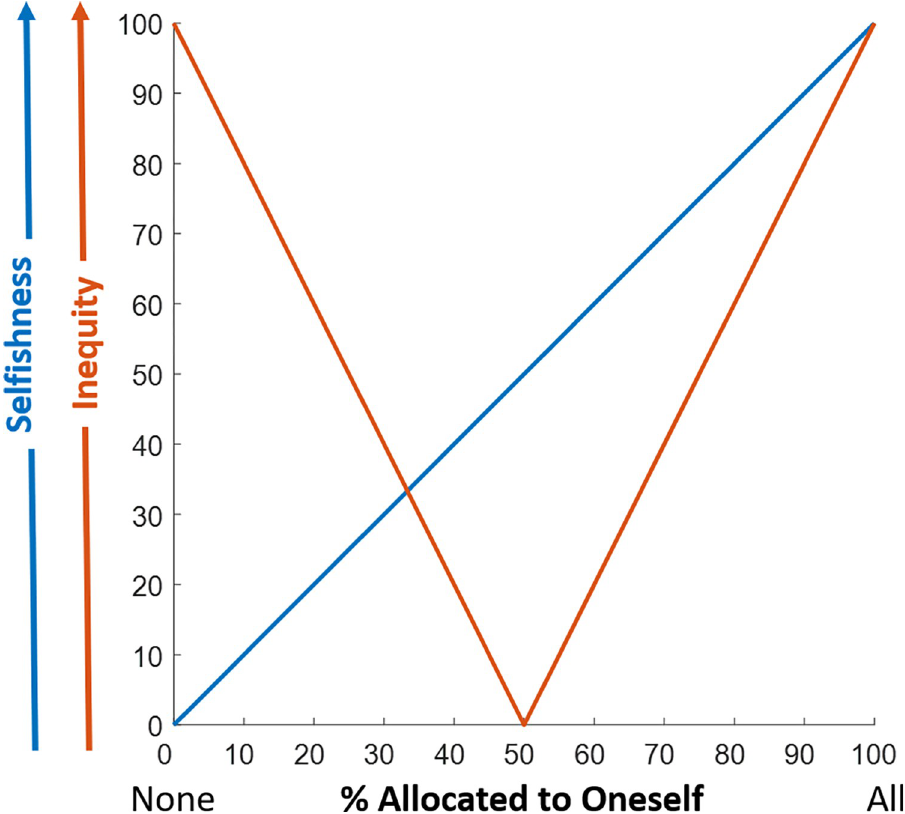
Fig 3. Operationalizing selfishness and inequality. Selfishness (blue line) is defined as the percentage of the endowment the allocator took/kept for themselves ranging from 0 (when the allocator is most generous, allocating nothing to themselves) to 100 (when the allocator is most selfish, allocating all to themselves). Inequality (orange line) is defined as the absolute difference between the percentages of the endowment each person is left with post allocation ranging from 0 (when the split was 50/50) to 100 (when one person receives all and the other none).